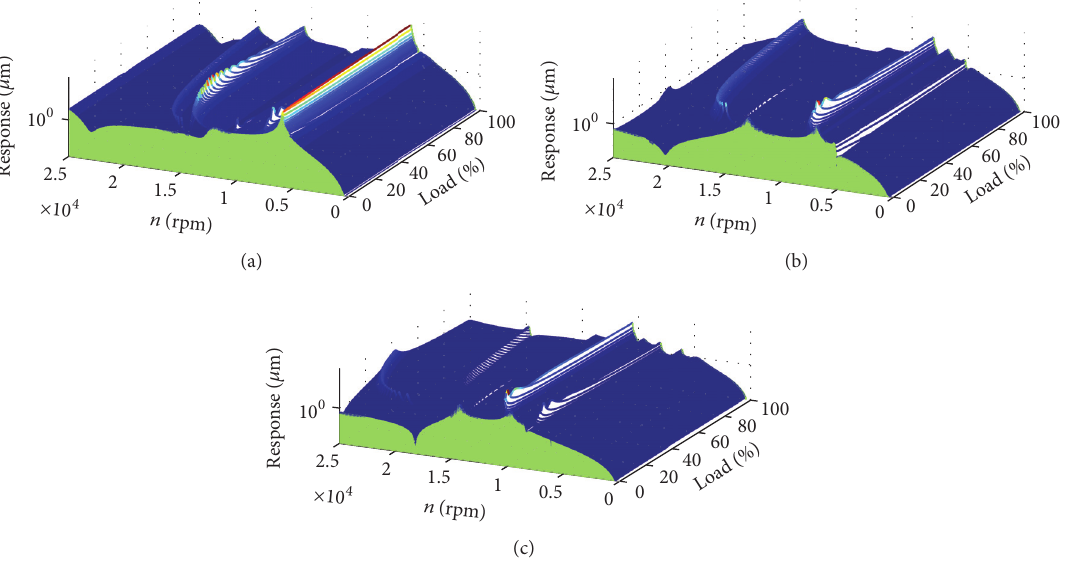
Figure 14: Unbalance response of three output shafts only considering gear meshing stiffness under varying workload, (a) output shaft 1, (b) output shaft 2, and (c) output shaft 3.